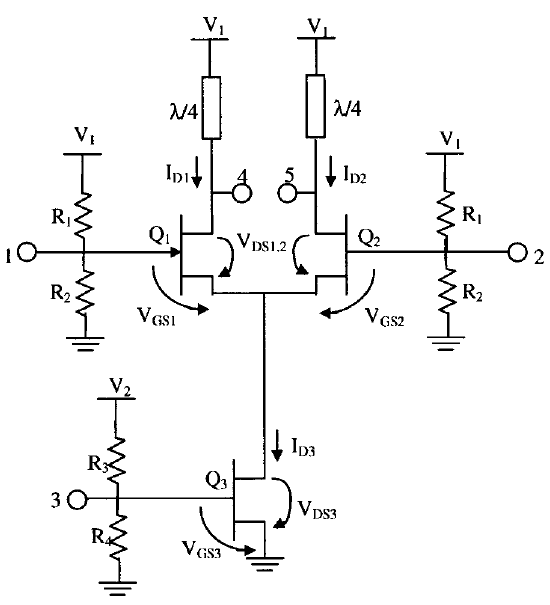
FIGURE 16 DC biased active part of the BPSK